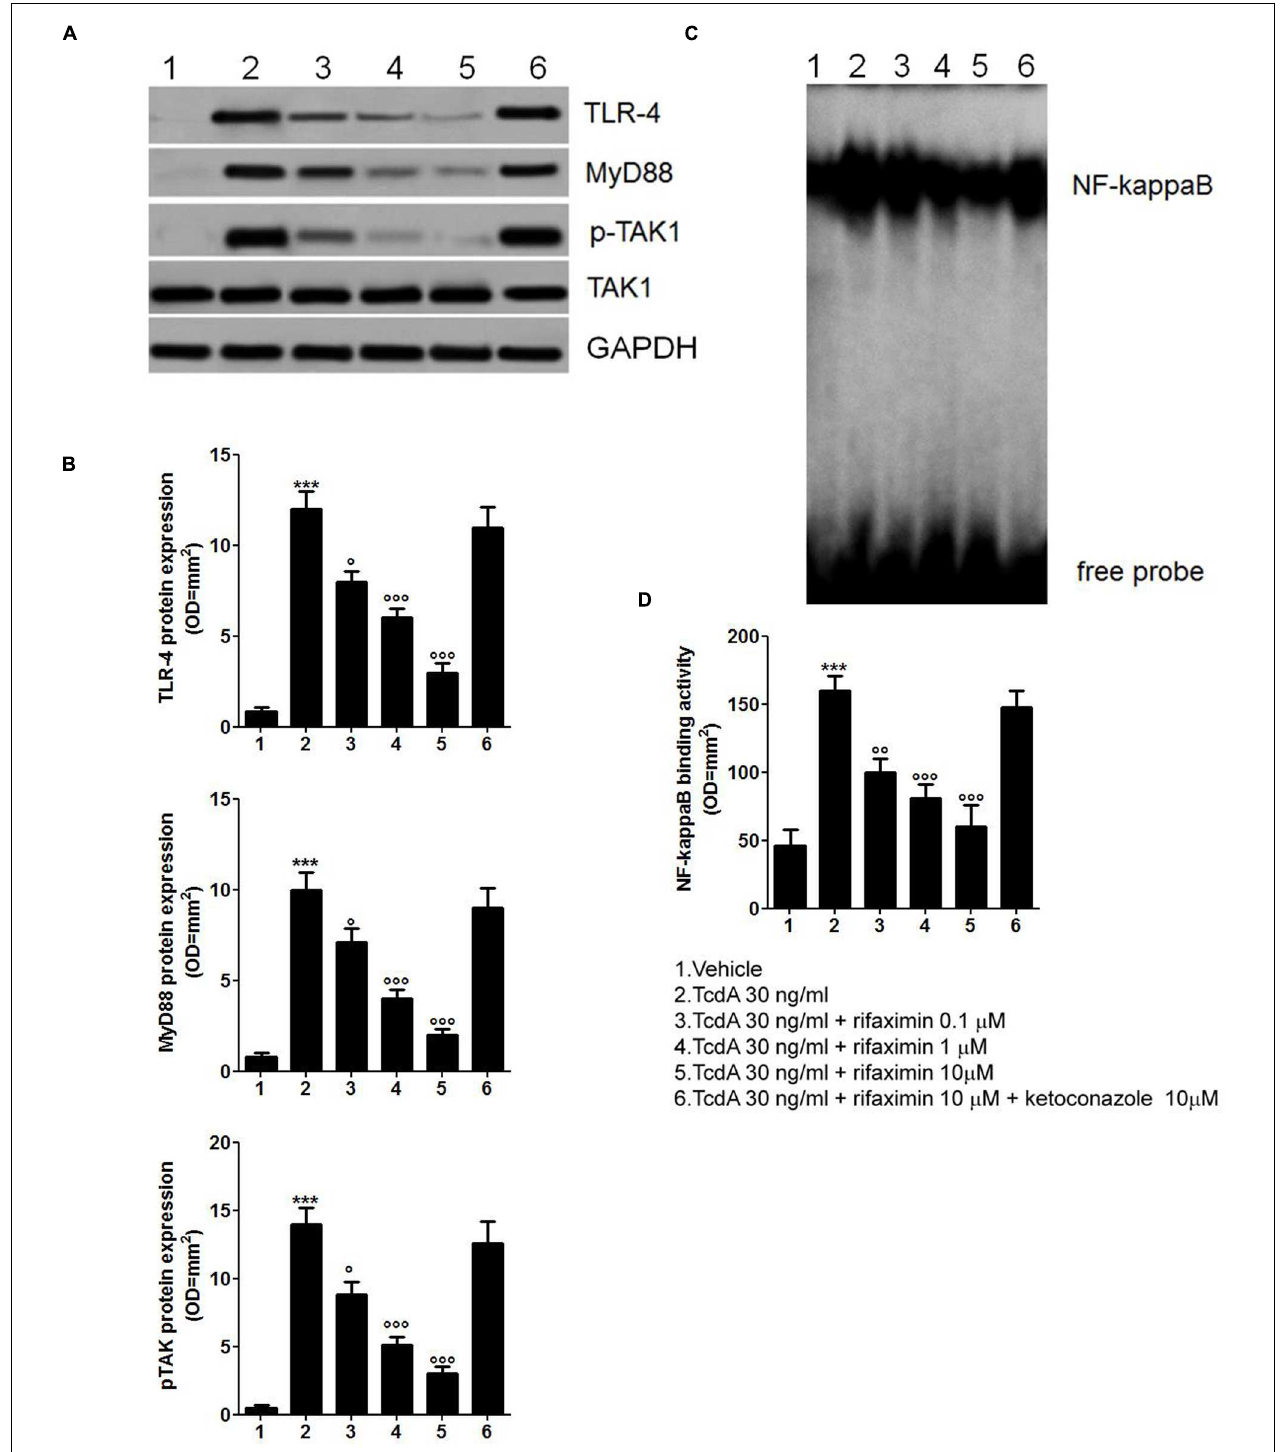
FIGURE 2 | Rifaximin (0.1, 1.0, and 10 µ M) down-regulates the TLR4/MyD88/NF- κ B pathway by a PXR-dependent mechanism. (A) Immunoblot showing the TLR4, MyD88, and phosphorylated/unphosphorylated TAK1 protein bands, and (B) Relative densitometric analysis of immunoreactive bands (arbitrary units normalized against the expression of the housekeeping GAPDH protein) showing the effects of rifaximin, given alone or in the presence of ketoconazole (10 µ M), on the expression of TLR4, MyD88, and pTAK1 in Caco-2 cell line. (C) EMSA analysis showing concentration-dependent inhibition of NF- κ B activation by rifaximin, and (D) Relative densitometric analysis of NF- κ B bands. Results are expressed as mean ± SEM of n = 5 experiments performed in triplicate. ∗∗∗ p < 0.001 vs. vehicle group; ◦◦◦ p < 0.001, ◦◦ p < 0.01 and ◦ p < 0.05 vs. TcdA group.